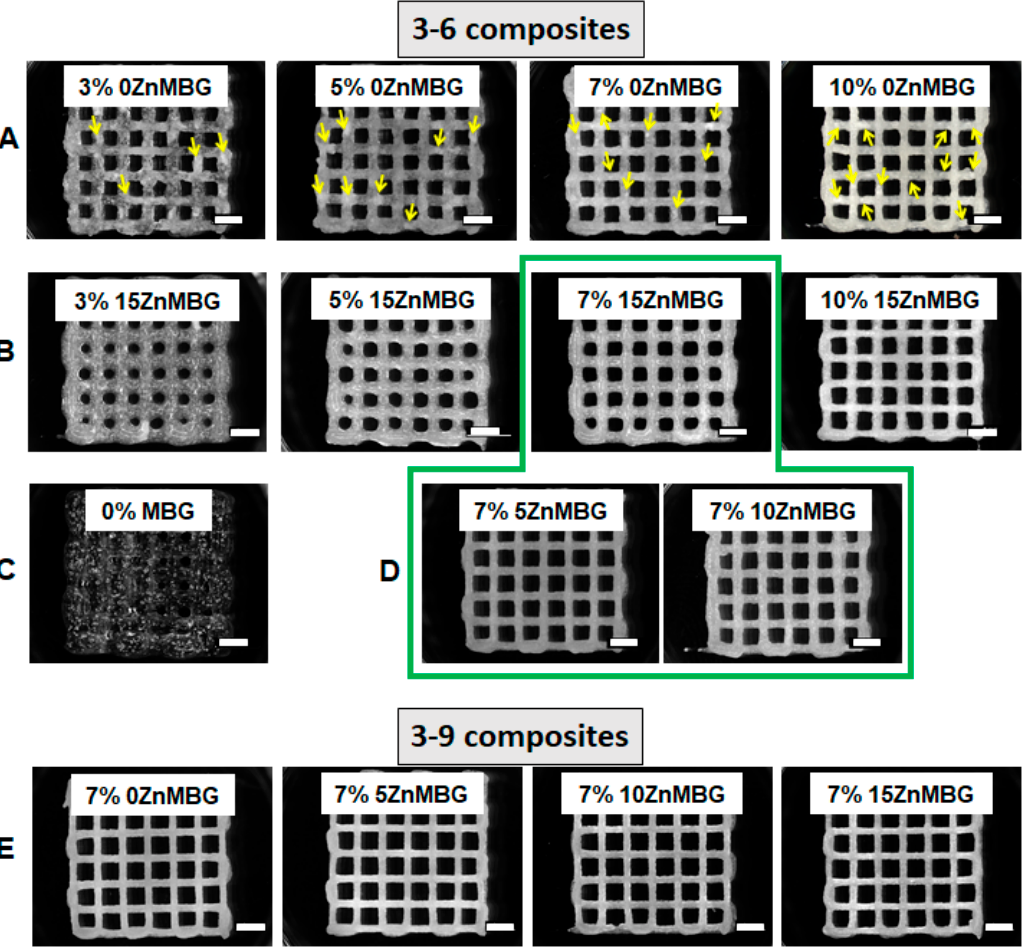
Figure 4. Stereo-light microscopic images of 3D scaffolds printed using different inks. ( A ) The 3–6 composite inks containing 3, 5, 7 and 10% of 0ZnMBG (15% Ca), yellow arrows show agglomerates of added MBG, ( B ) 3–6 composite inks containing 3, 5, 7 and 10% 15ZnMBG (0% Ca), ( C ) 3–6 ink without any MBG, ( D ) 3–6 composite inks containing 7% of 5ZnMBG (10% Ca) and 7% of 10ZnMBG (5% Ca). Green line marks selected combinations of 3–6 composite inks for further experiments, ( E ) 3–9 composite inks containing 7% of each ZnMBG. Scale bars represent 2 mm.